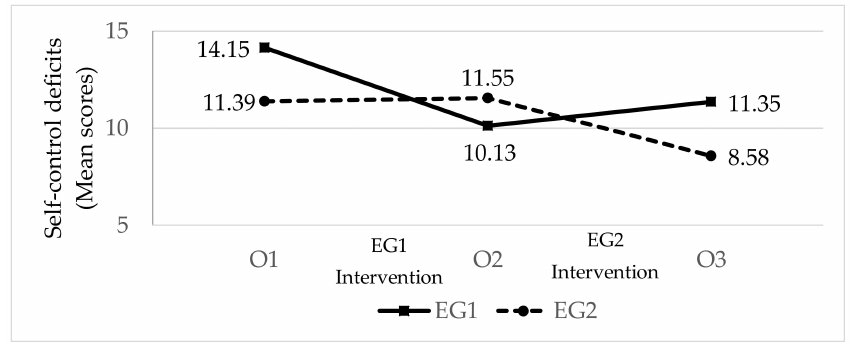
Figure 2. The e ff ect of the intervention on pupils’ self-control deficits (n GE1 = 40; n GE2 = 33; EG = Experimental Group; O = Observation).